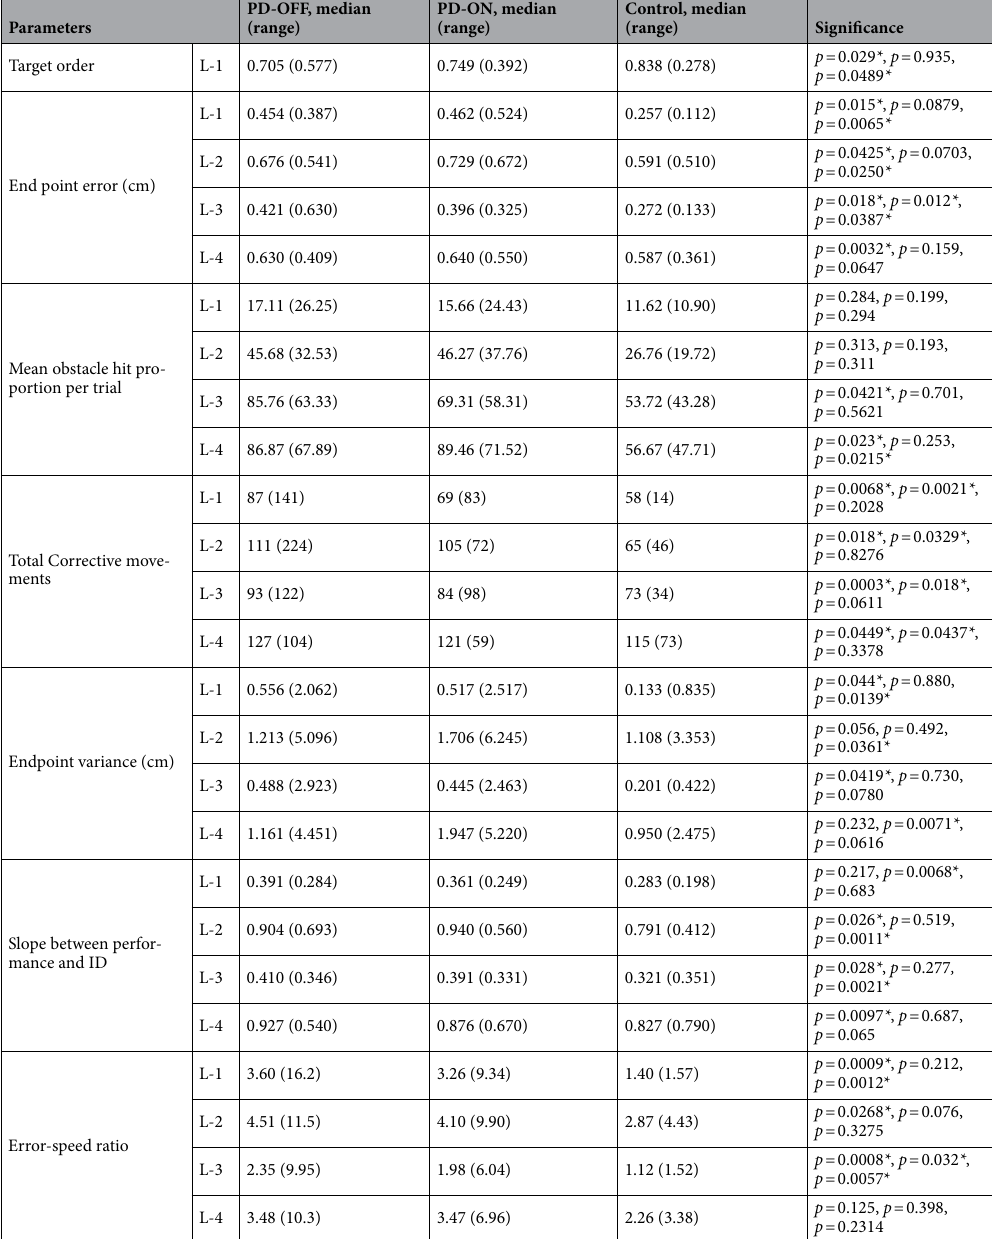
Table 4. Extracted features for the three groups and the corresponding statistical significance. The first value in the significance column corresponds to PD-OFF vs. controls; the second value corresponds to the PD-OFF vs. PD-ON; the third value corresponds to the PD-ON vs. controls; * after the p -value indicates statistical